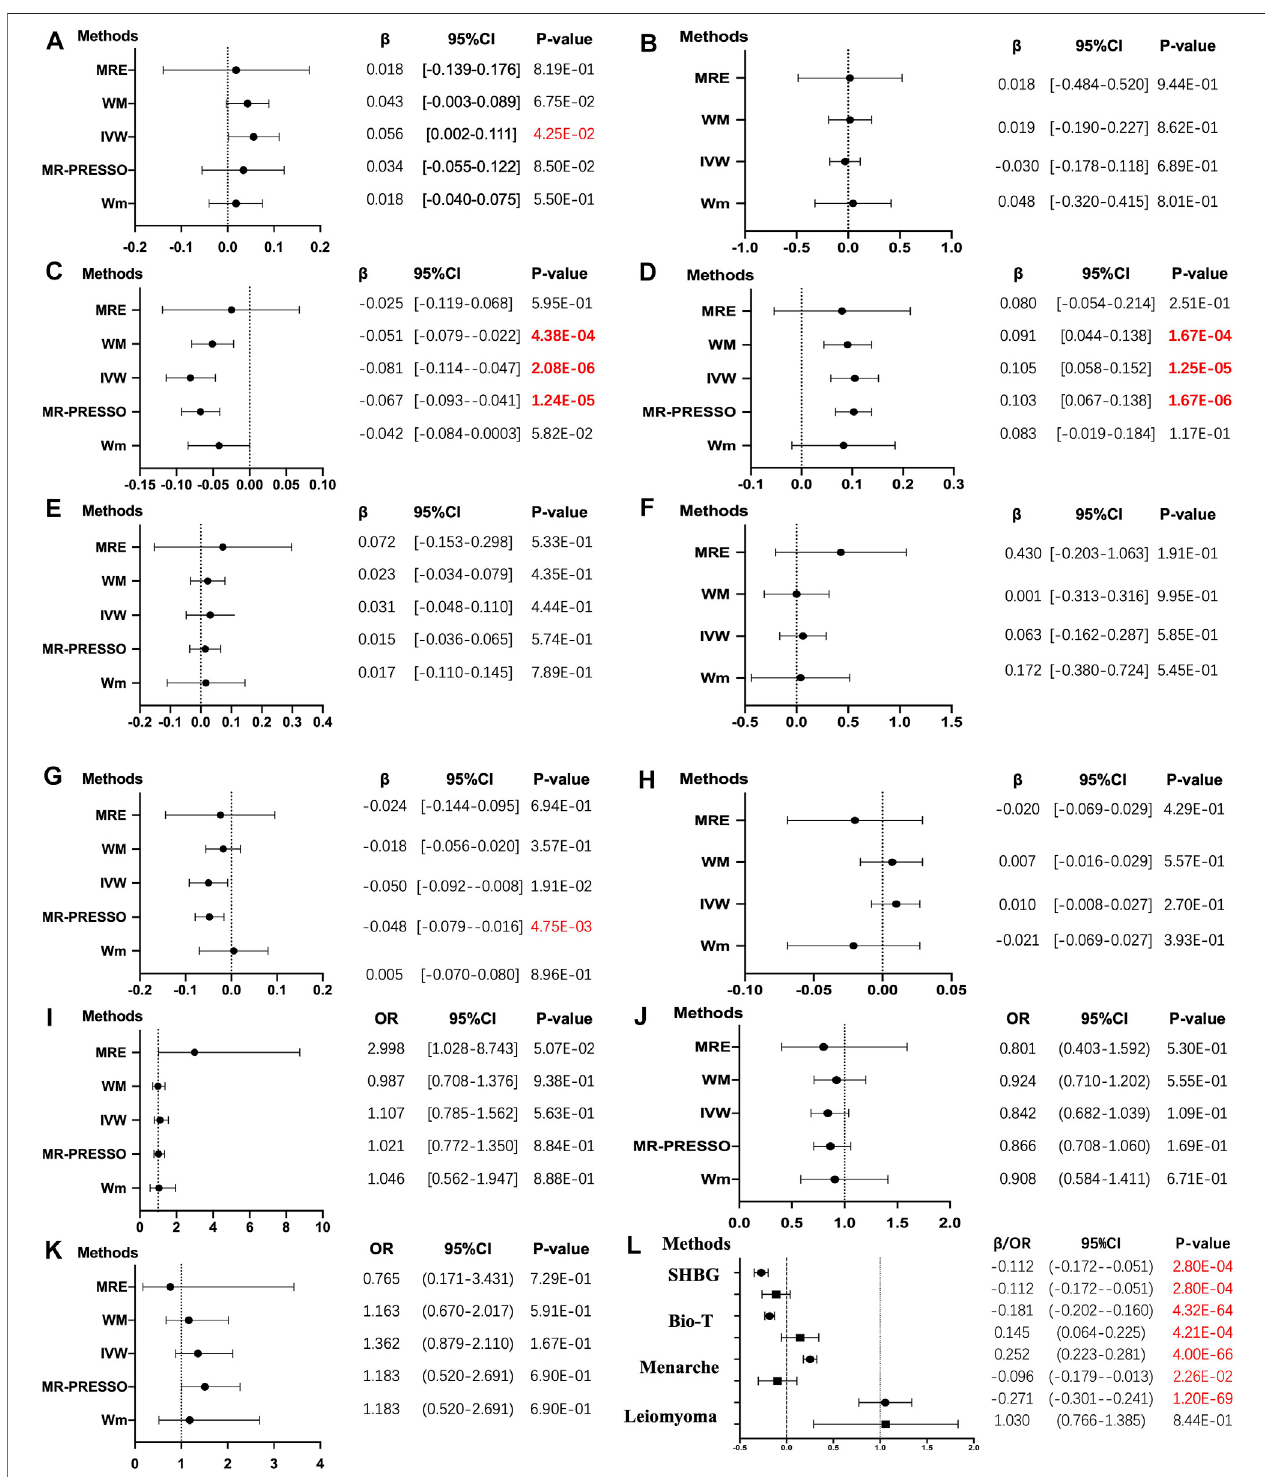
FIGURE 1 | The results of four different methods of Mendelian randomization (MR) analysis. (The MR analysis showing the effect of the exposure SNPs on the outcomes. (A – K) : (A) body mass index, BMI; (B) estradiol, E 2 ; (C) sex hormone-binding globulin, SHBG; (D) bioavailable testosterone, bio-T; (E) total testosterone, TT; (F) anti-Mullerian hormone, AMH; (G) menarche; (H) menopause; (I) endometriosis; (J) leiomyoma; (K) polycystic ovarian syndrome, PCOS. (L) in the multivariable MR analysis, each trait with two results is presented. The solid dot means the causal effects of LBW on traits, whereas the square means BMI on traits in the MVMR. MRE, MR-Egger; WM, weighted median; Wm, weighted mode; IVW, inverse variance weighting; MR-PRESSO, MR-Egger and Mendelian Randomization Pleiotropy RESidual Sum and Outlier. The results of the continuous outcomes are presented by β [95% CI], whereas the binary outcomes are shown by OR [95% CI]. Numbers in red mean p- values < 5.00E-02 and red and bold font means p- values < 4.55E-03)